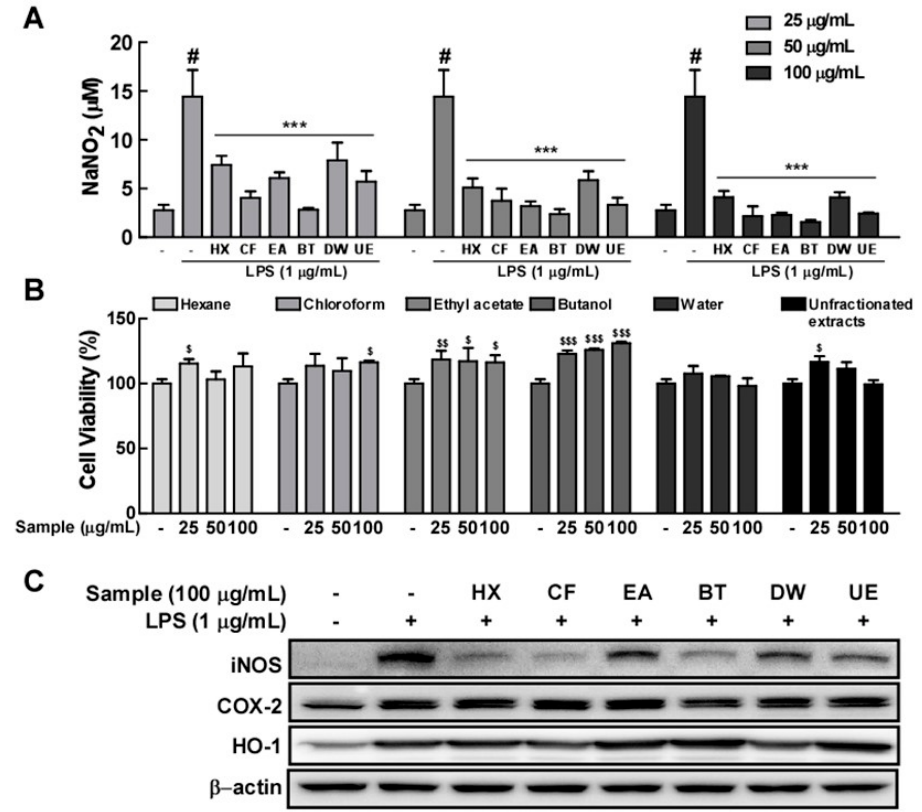
Figure 6. Effect of each component of EJE on LPS ‐ induced NO production and iNOS, COX ‐ 2, and HO ‐ 1 expression in BV2 cells. EJE was fractionally extracted using the following succession of organic solvents: hexane (HX), chloroform (CF), ethyl acetate (EA), butanol (BT), and residual water (DW) fractions. In this Figure, the unfractionated hot water extract of Erythronium japonicum is expressed as unfractionated extract (UE). (A) The butanol extracted fraction of EJE was most active among organic solvent extracted fractions in reducing LPS ‐ induced NO production in BV2 cells. NO contents were confirmed by the Griess reagent, as indicated in the Materials and Methods section. (B) No fraction of EJE induced any cell toxicity at concentrations ranging from 25 to 100 μ g/mL. (C) The butanol fraction of EJE decreased LPS ‐ induced iNOS and COX ‐ 2 and distinctly induced HO ‐ 1 expression in BV2 cells. Expression levels were confirmed by each antibody, as described in Materials and Methods. Hash symbols (#) indicate a significant difference ( p < 0.001) between the control group and the group exposed to LPS alone; asterisks (*, **, and ***) indicate significant differences ( p < 0.05, p < 0.01, and p < 0.001, respectively) between the groups co ‐ treated with LPS and samples and the group exposed to LPS alone. In cell viability test, dollar signs ($, $$, and $$$) indicate significant differences ( p <0.05, p < 0.01, and p < 0.001, respectively) between the control groups and the groups treated samples. In this and all the following Figures, data are presented as the mean ± SEM of three independent experiments.